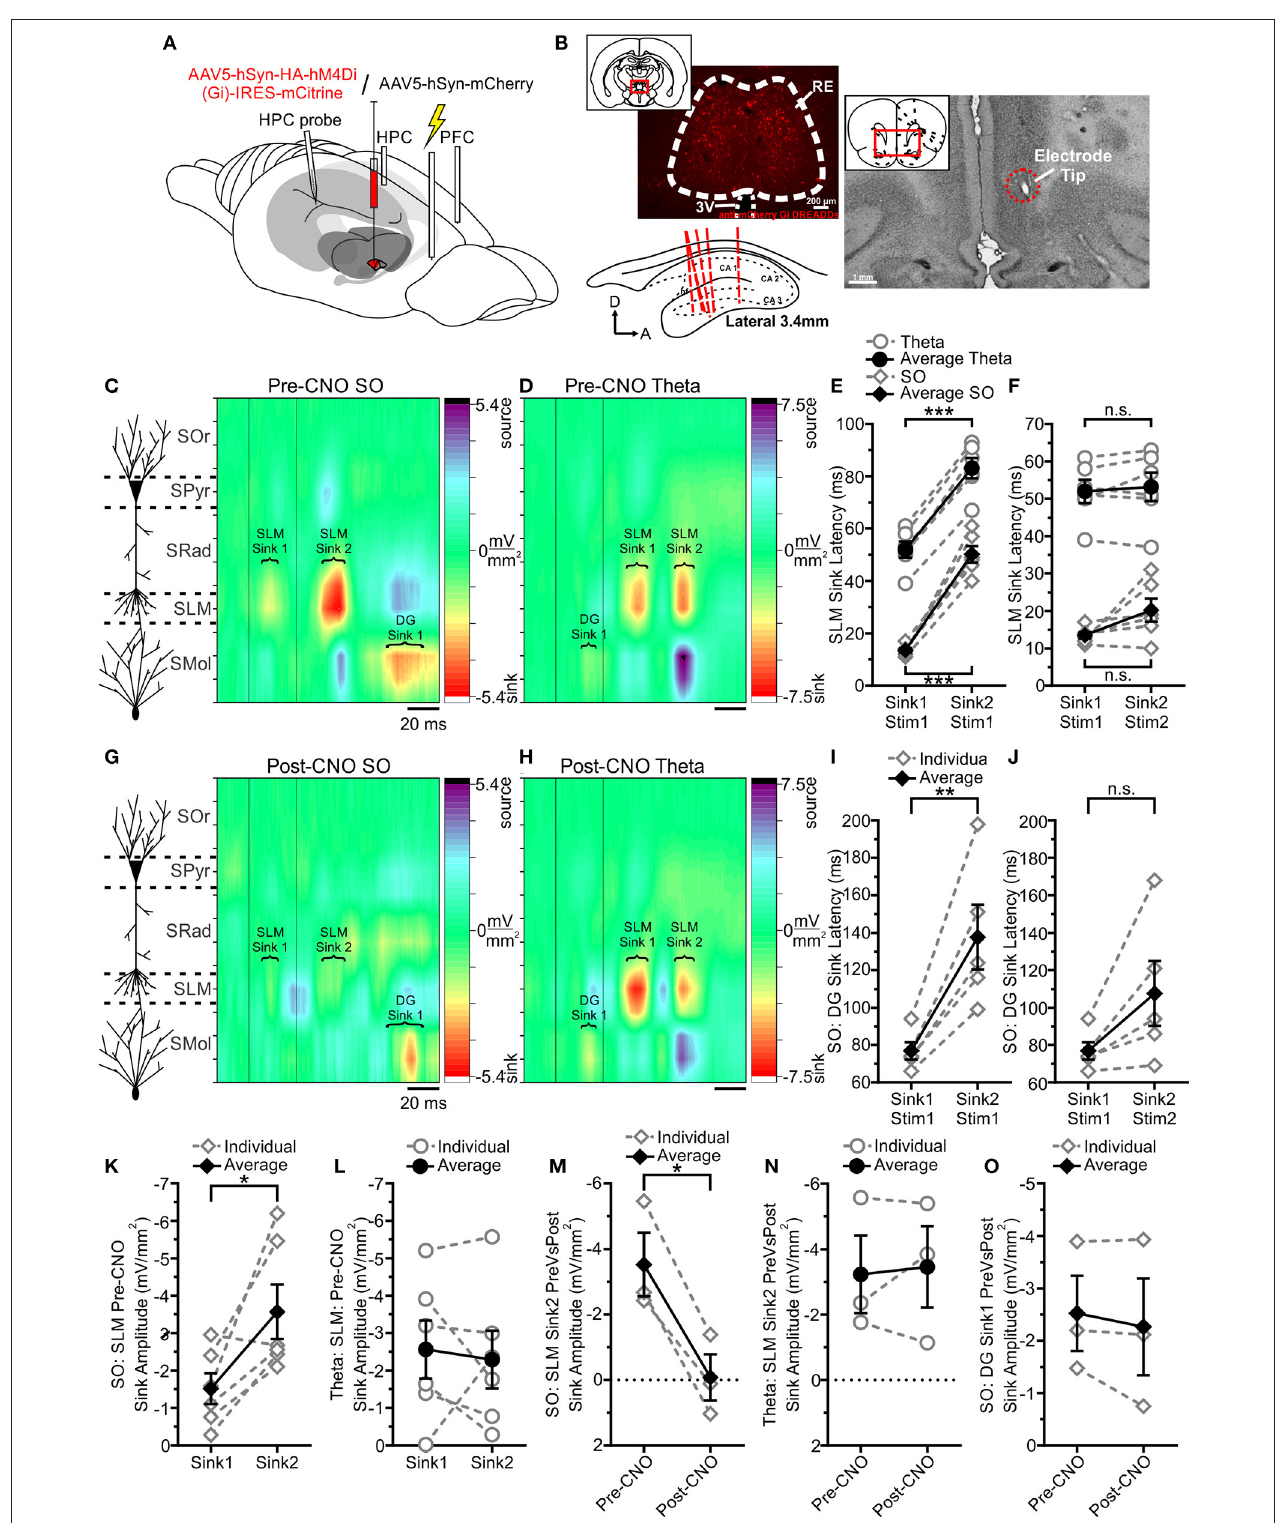
FIGURE 6 | Infralimbic stimulation evokes a different pattern of responding in HPC as a function of state, which RE mediates. (A) Schematic illustration of the recording, injection, stimulation, and inhibition sites. Schema modified from Amaral and Witter (1995). (B) Originally published in Hauer et al. (2019), with modifications. Representative coronal tissue section showing expression of hSyn-hM4Di-HA-mCitrine virus localized to RE. Inset, Schematic of the relative location of the image. Top